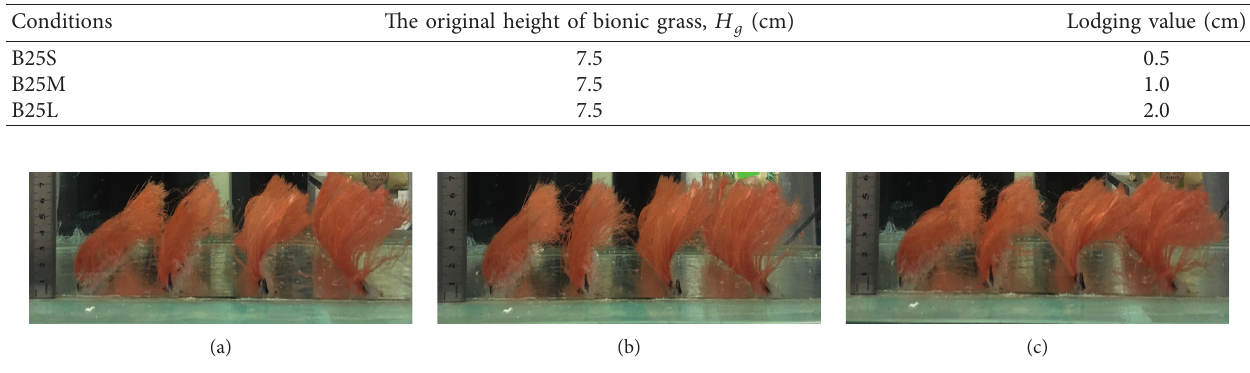
Figure 2: Lodging values of bionic grass at different flow rates. (a) v � 0.18m/s. (b) v � 0.22m/s. (c) v �